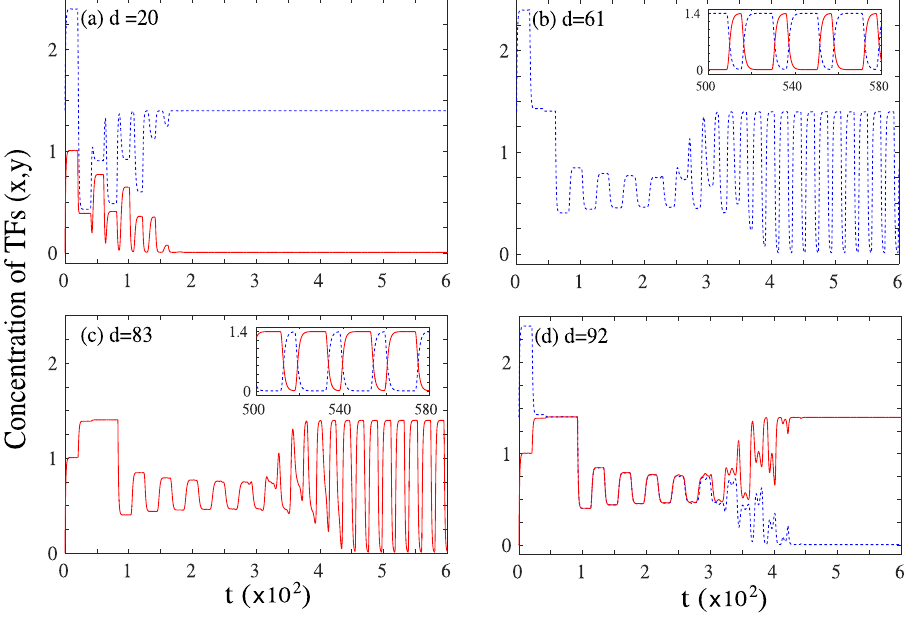
Figure 3. Time series of the concentrations of the two transcription factors ( x / y ) in regime B for four different drive times for τ = τ 1 = τ 2 = 20. ( a ) d = 20: System stays in initial undifferentiated state; ( b ) d = 51: Sustained oscillations in concentration of TFs. The main panel shows a single TF ( x ) while the inset shows a magnified view of both the TFs in a narrow window of time; ( c ) d = 83: Sustained oscillations in concentration of TFs. The main panel shows a single TF ( y ) while the inset shows a magnified view of both the TFs in a narrow window of time; ( d ) d = 92: Transdifferentiation to the other differentiated